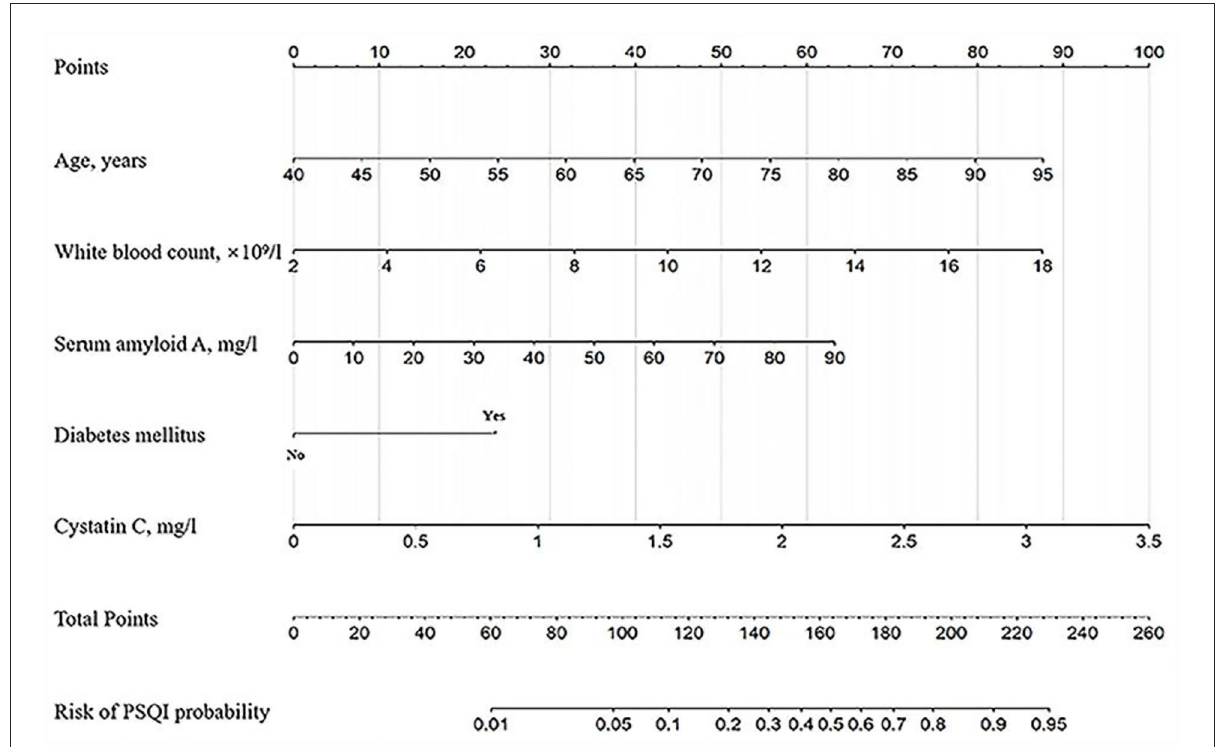
FIGURE2 The nomogram for predicting the risk of PSCI probability based on the 5 independent prognostic factors. For example, a 65-year-old (40 points) patient with diabetes mellitus (25 points) with white blood counts of 12.0 × 10 9 /L (55 points), serum amyloid A of 50 mg/L (35 points), and cystatin C of 1.5 mg/L (42 points) arrived at a total point of 197, with a probability of 80% to develop